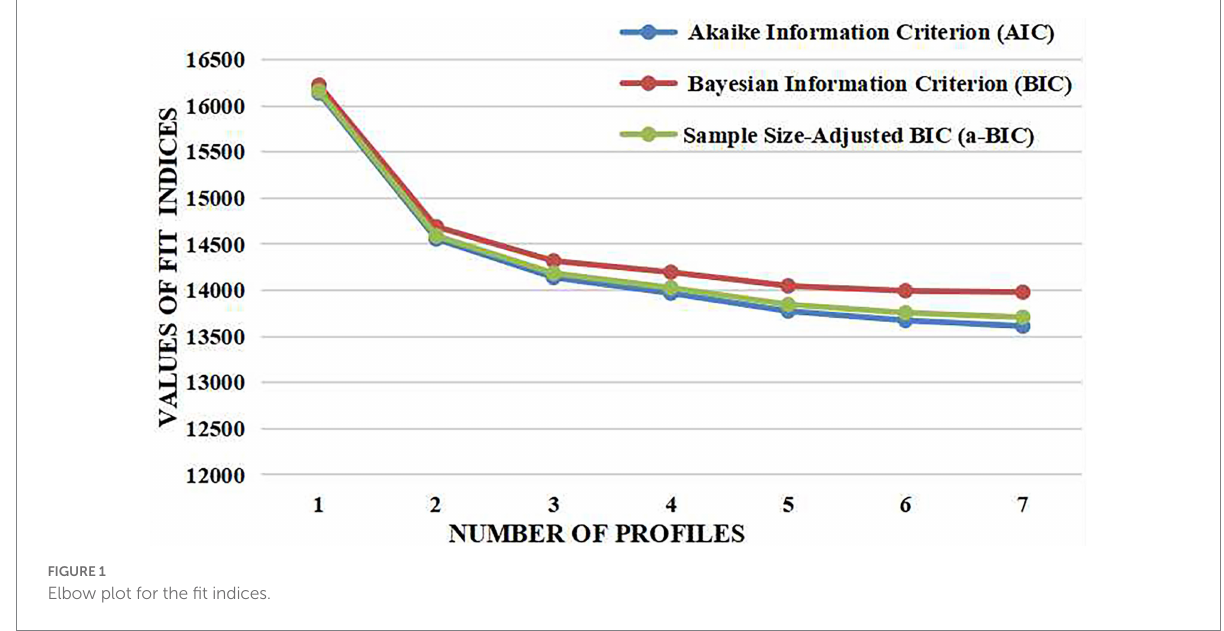
FIGURE 1 Elbow plot for the fit indices.